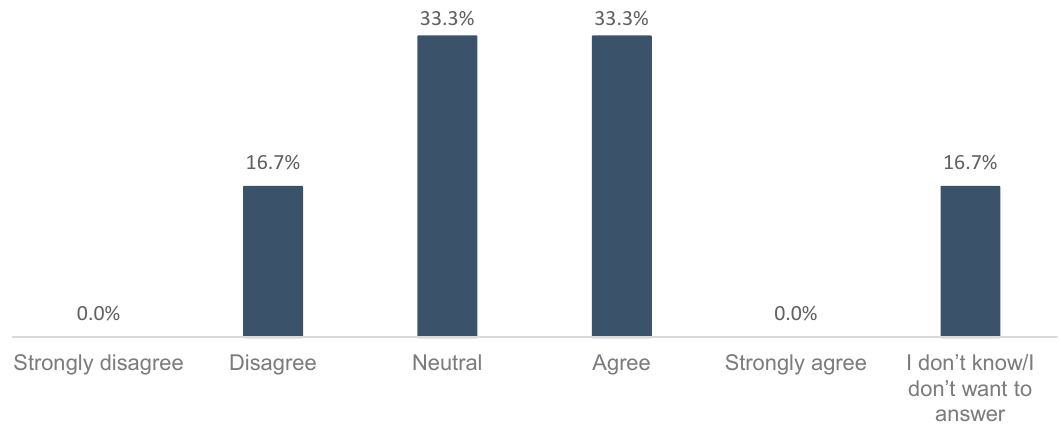
Figure 18. Editable blockchain.